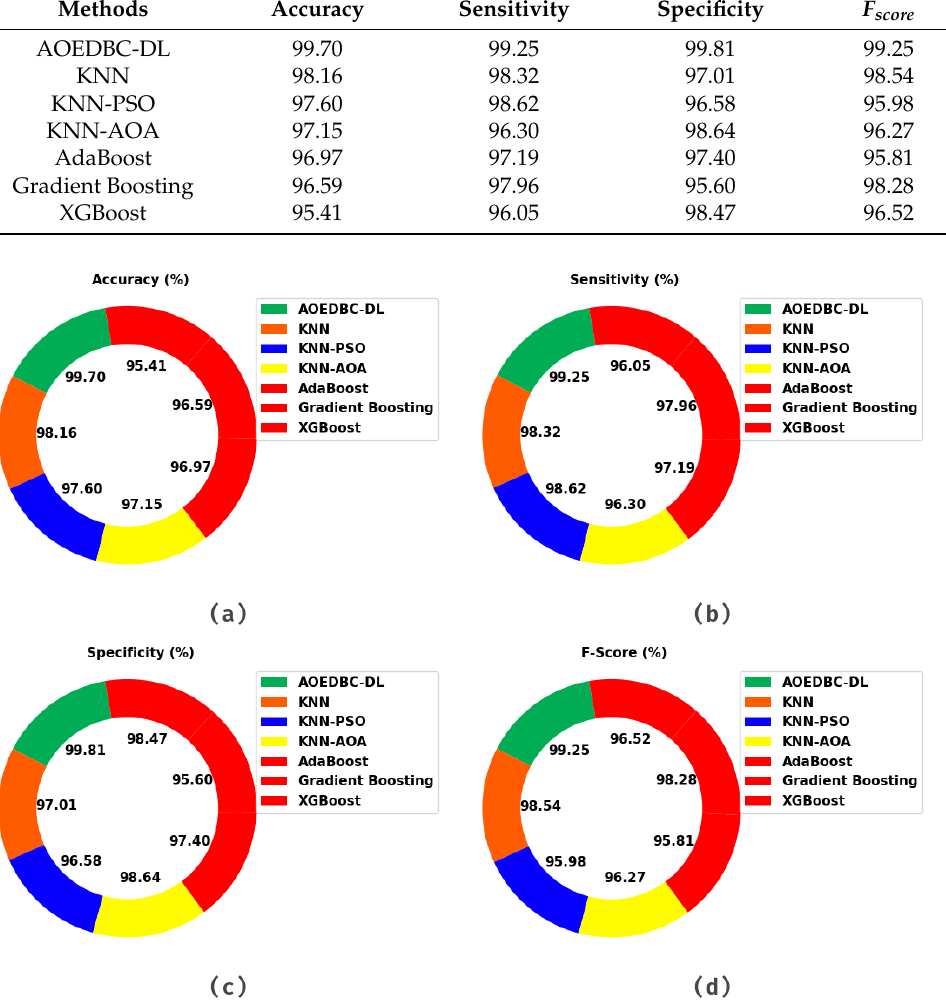
Figure 9. Comparative analysis of AOEDBC-DL system ( a ) 𝑎𝑐𝑐𝑢 𝑦 , ( b ) 𝑠𝑒𝑛𝑠 𝑦 , ( c ) 𝑠𝑝𝑒𝑐 𝑦 , and ( d ) 𝐹 𝑠𝑐𝑜𝑟𝑒 .